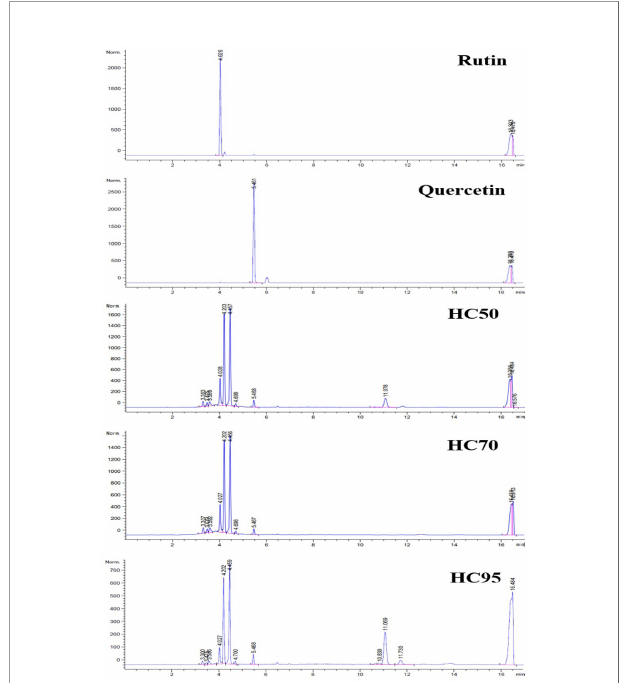
FIGURE 1 | High-performance liquid chromatography (HPLC) chromatograms of rutin, quercetin, HC50, HC70, and HC95.